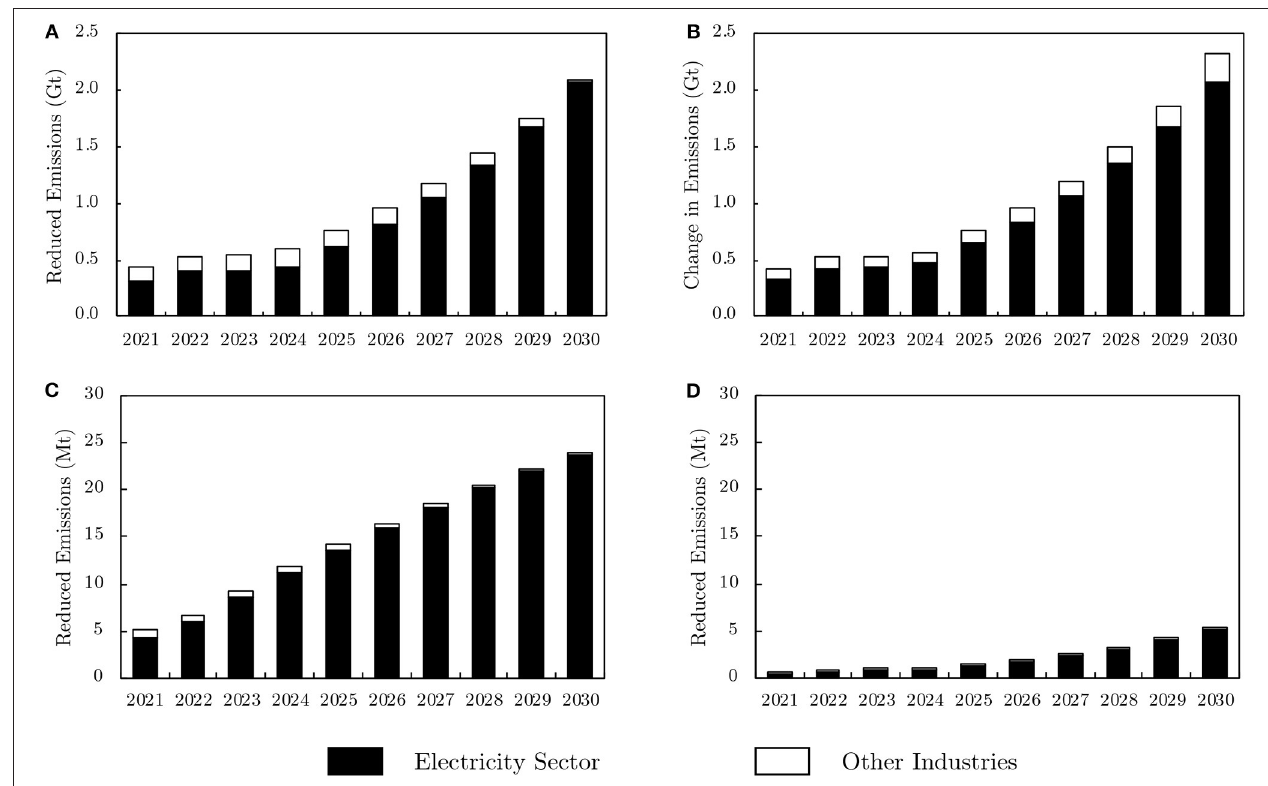
FIGURE 3 | Carbon mitigation under moderate mitigation scenarios (vs. BAU Levels): (A) China, PARIS ; (B) China, PARIS_INT ; (C) Hong Kong, PARIS ; (D) Hong Kong, PARIS_INT